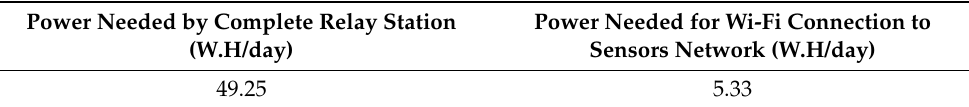
Table 9. Daily energy